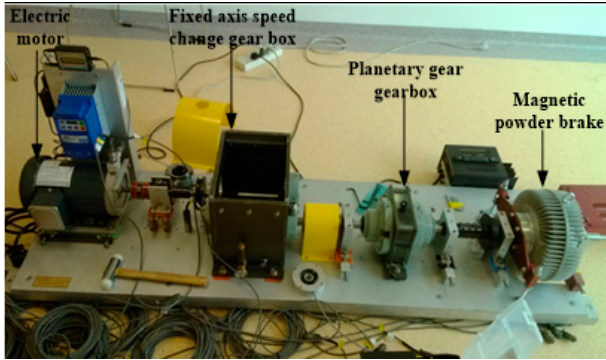
Figure 8. Machinery fault simulator (MFS)-magnum experiment.